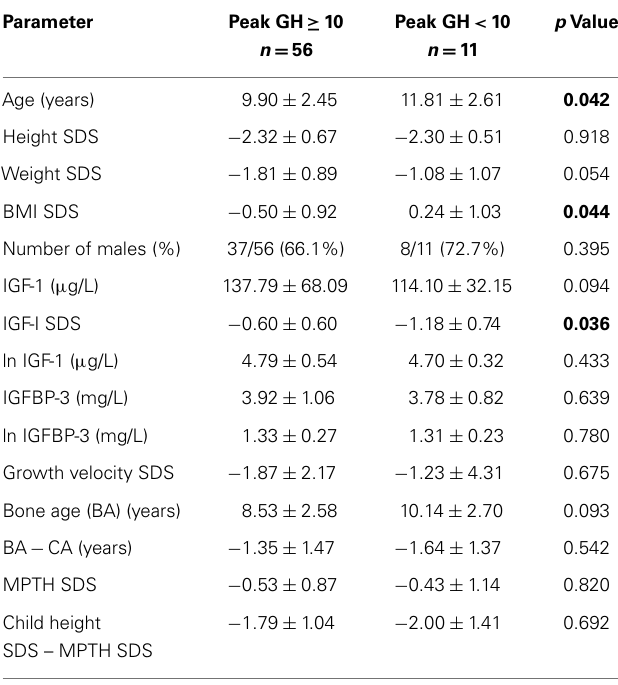
Table 2 | Characteristics of prepubertal subject stratified by peak growth hormone level of 10 µ g/L